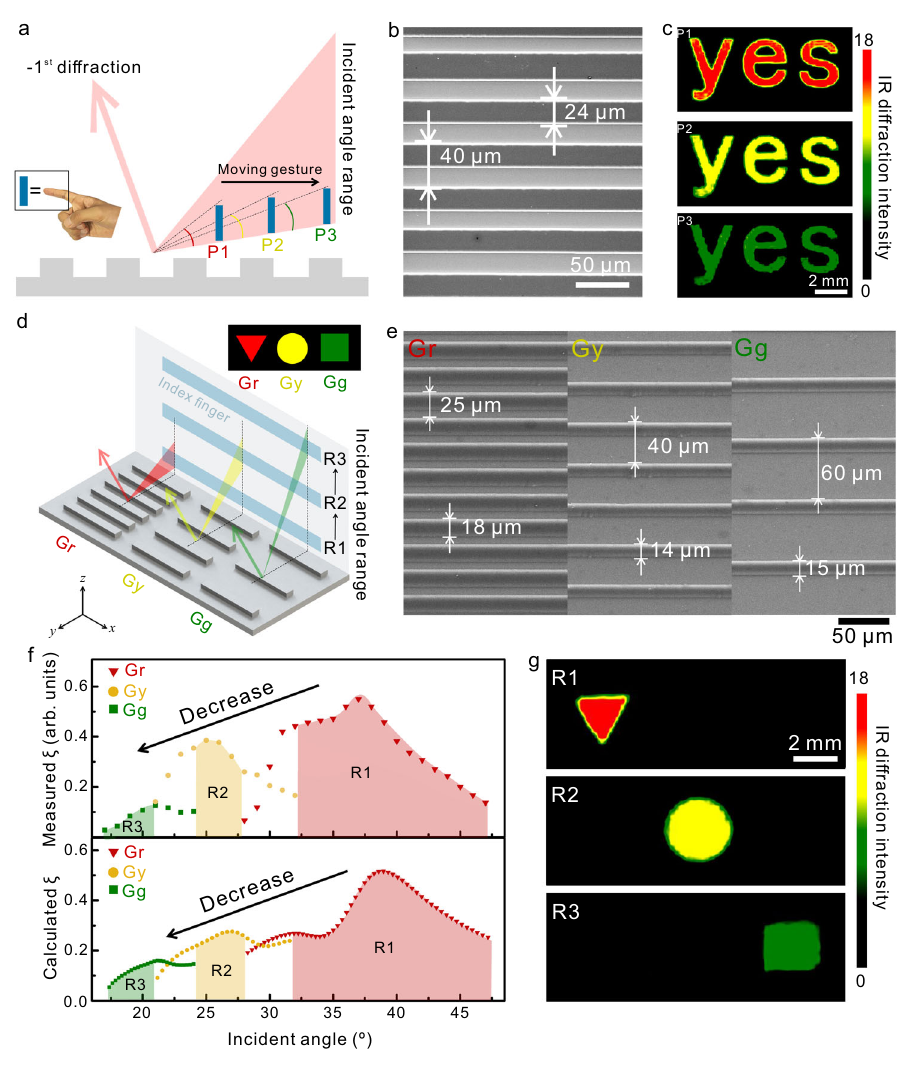
Fig. 3 Interaction between the fi nger and gratings for the generation of dynamic IR structural colors. a Schematic illustration of the interaction between the fi nger and one single grating. b The SEM image of the fabricated gratings. c IR images generated through moving the fi nger away from the gratings. d Schematic illustration of the interaction between the fi nger and different gratings; The red, yellow, and green areas represent the incident angle ranges of Gr, Gy, and Gg, respectively. e SEM images of gratings. f Experimentally measured − 1st diffraction ef fi ciency (arbitrary units, arb. units) of different gratings (top) and FDTD calculated − 1st diffraction ef fi ciency of different gratings (bottom). g IR images generated by moving the fi nger